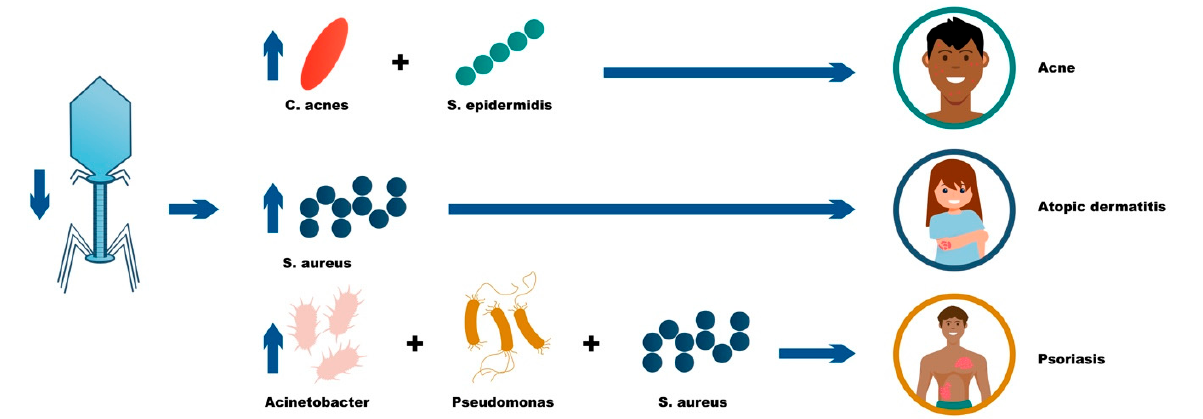
Figure 1. The influence of phage deficiency in acne, atopic dermatitis, and psoriasis.